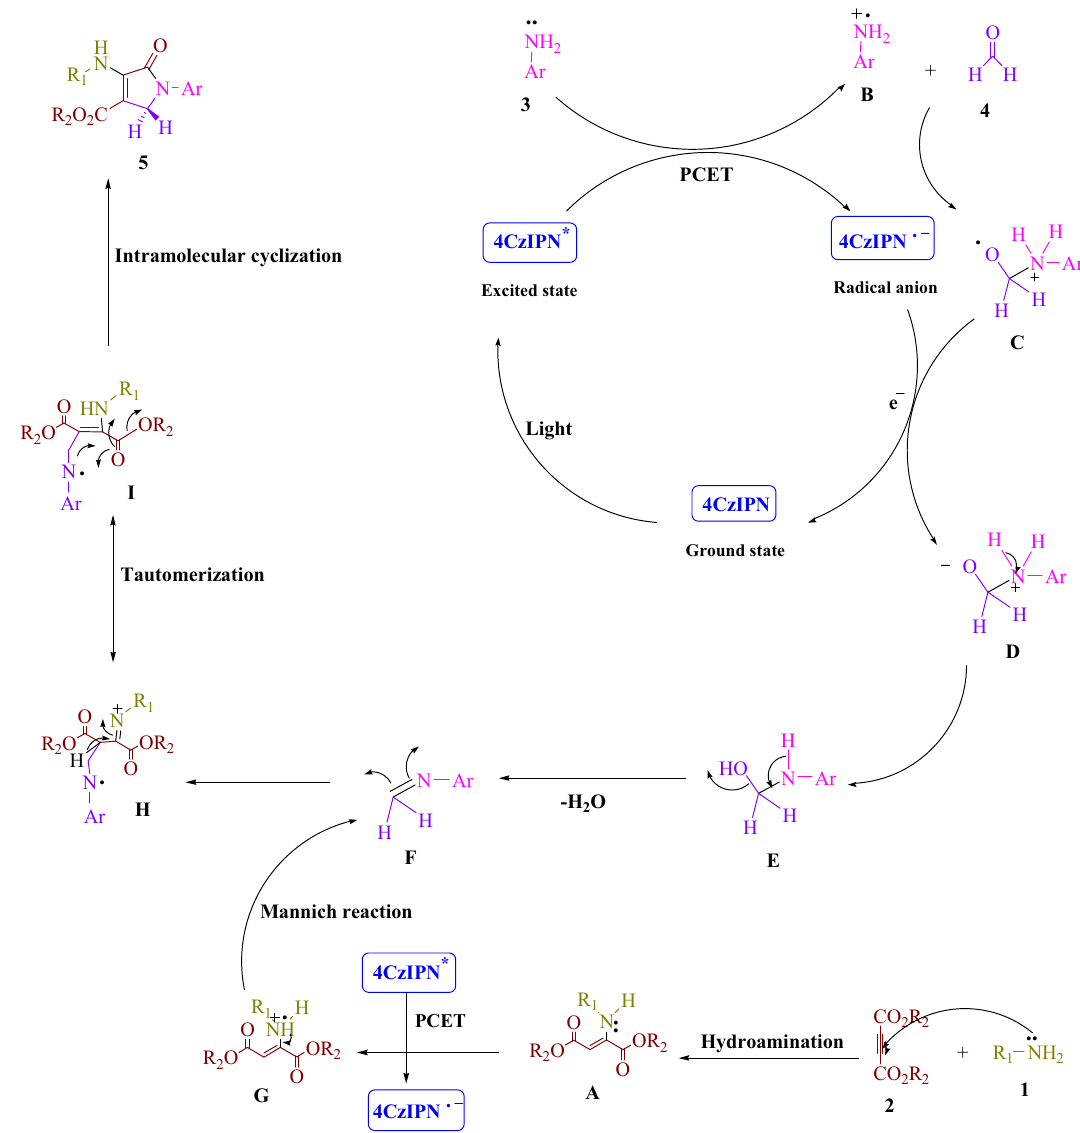
Figure 6. There was a detailed description of the mechanism of synthesis of polyfunctionalized dihydro-2-